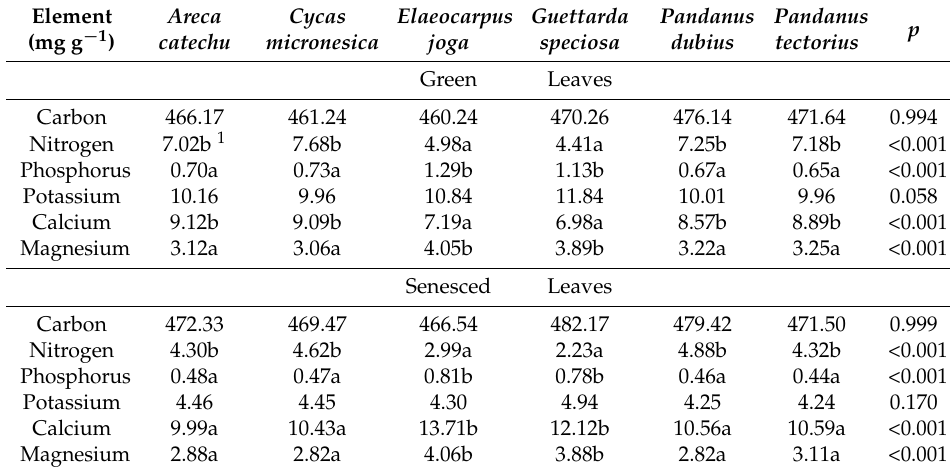
Table 1. Concentration of carbon and macronutrients in green and senesced Dendrobium guamense leaves as influenced by host tree identity ( n =